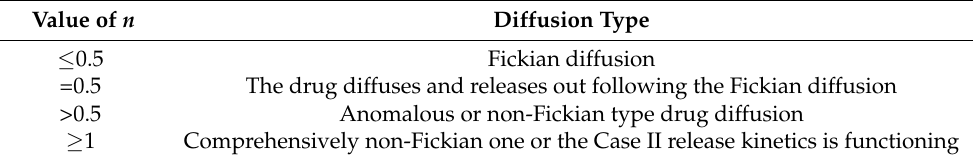
Table 1. Fickian and non-Fickian diffusion with respect to n values. Value of n ≤ 0.5 =0.5 The drug diffuses and releases out following the Fickian diffusion